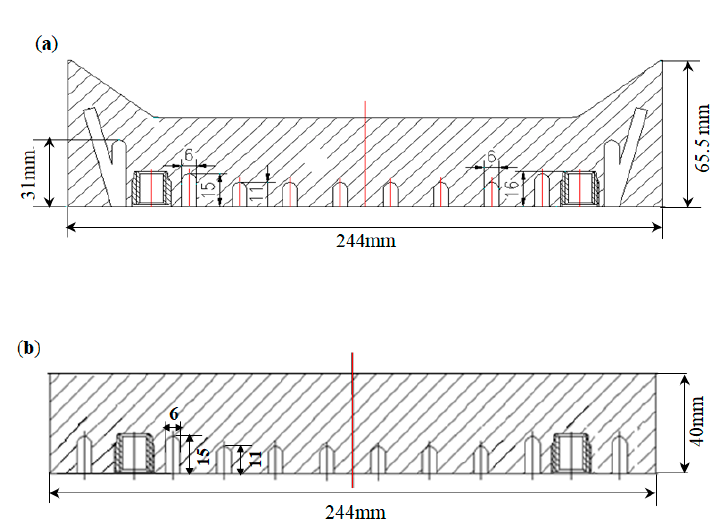
Figure 4. The narrow face of mold. ( a ) The narrow face of chamfered mold; ( b ) The narrow face of common mold.